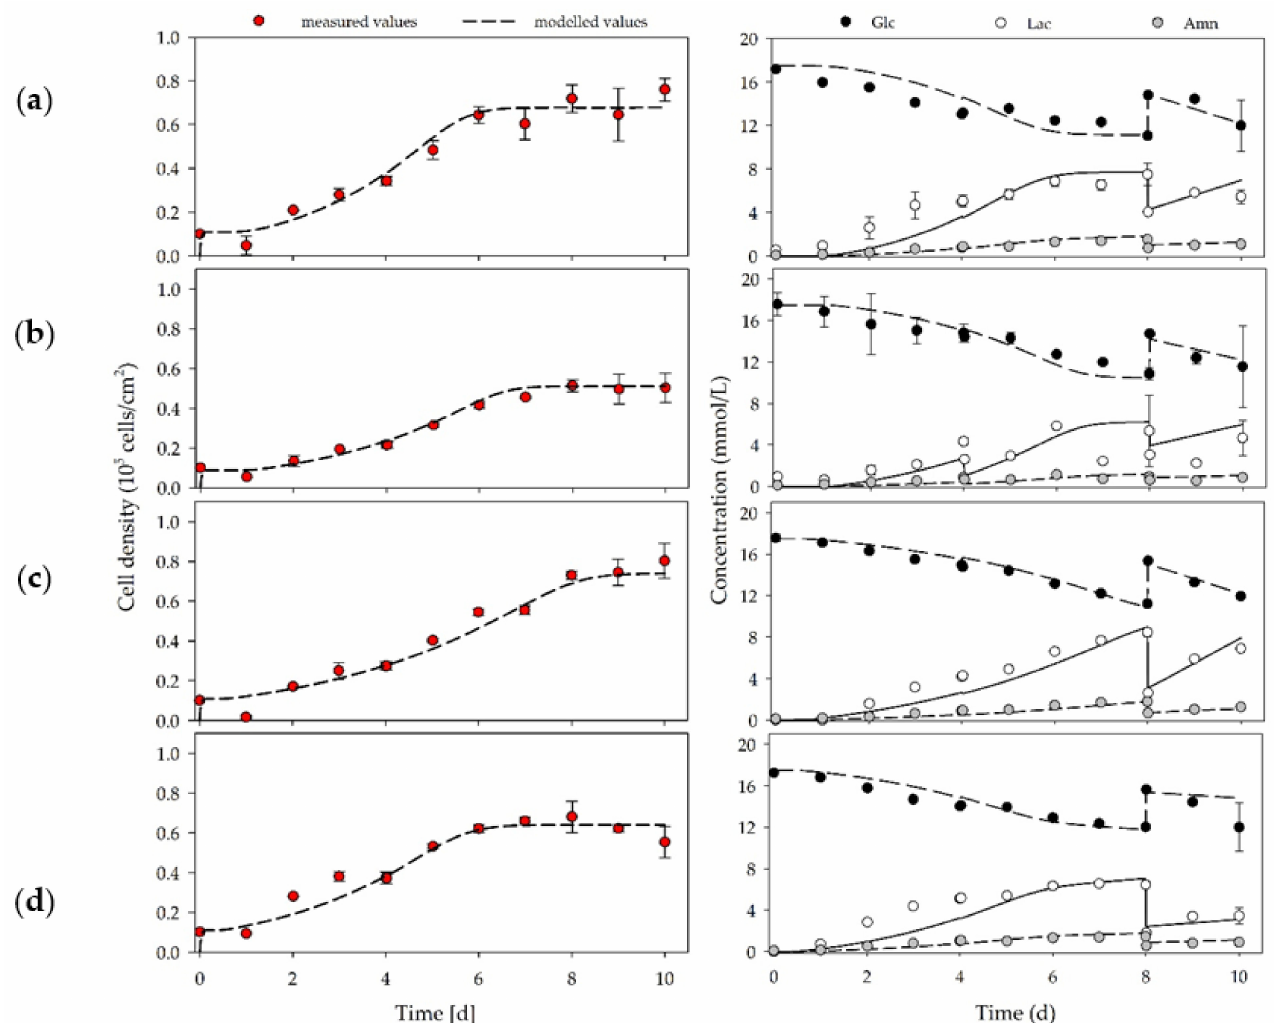
Figure 4. Time-dependent profiles of cell densities (left) and substrate/metabolite concentrations (right) in T 25 -flasks (n = 2 per donor). D-I ( a ), D-II ( b ), D-III ( c ), and D-IV ( d ). Partial medium exchanges of 40% and 60% were performed on days 4 and 8, respectively. The symbols represent the experimentally measured values collected from offline measurements. The lines represent the simulated time